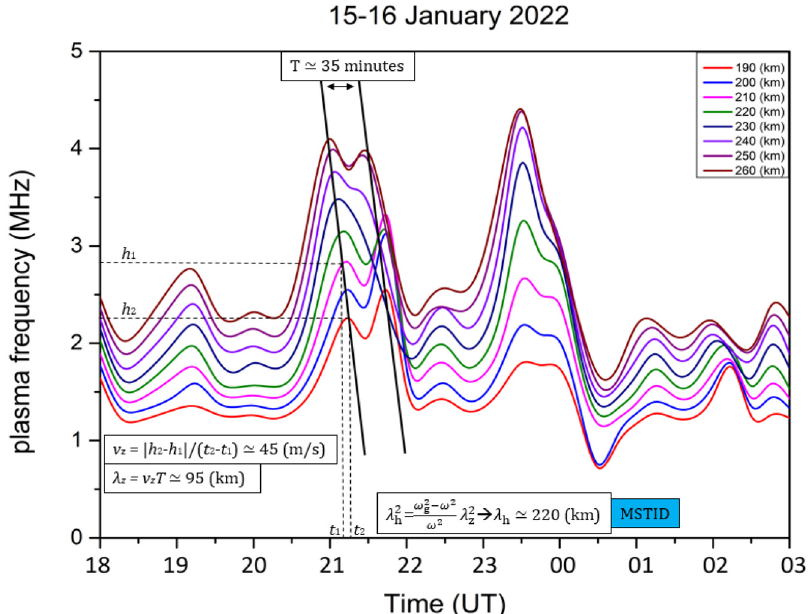
Figure 10. Electron density variations for the real height range of 190–260 km, computed between 15 January 2022 at 18:00 UT and 16 January 2022 at 03:00 UT. Oblique lines highlight the downward phase shift typical of gravity wave propagation.